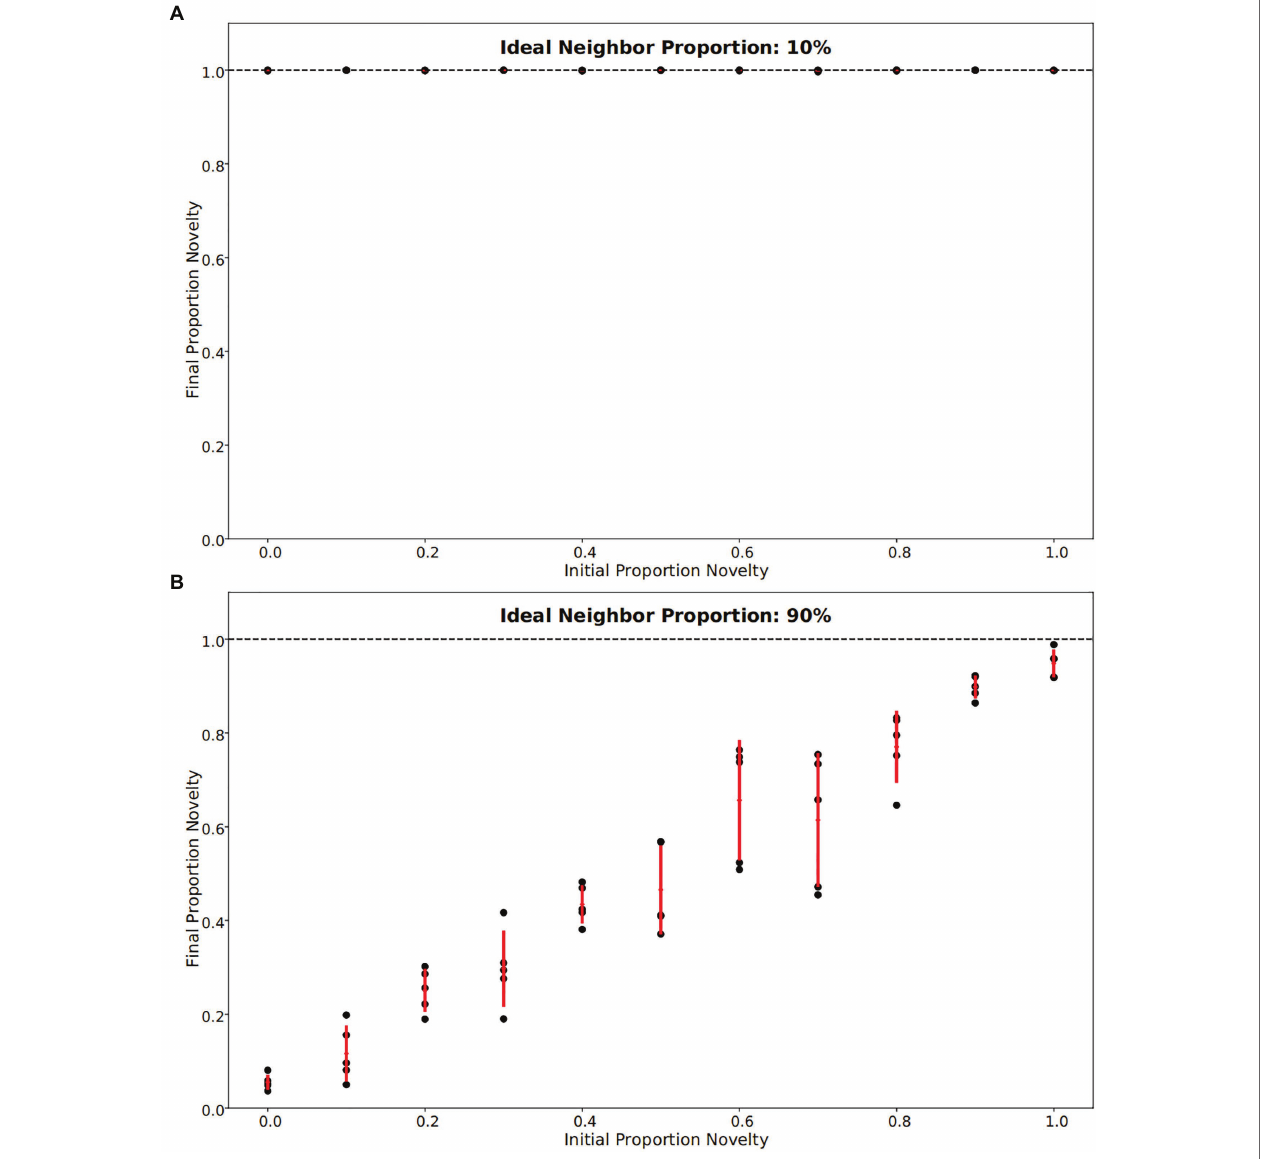
FIGURE 1 | Final fraction of novelty preference in the population after 4,000 iterations, for a range of initial novelty preferences. Each of five replicates per ideal neighbor proportion are represented by a black point, with one standard deviation from the mean marked by red lines. (A) For populations in which rare cultural traits are favored (an ideal neighbor proportion of 10%), novelty preference was strongly selected for, such that all populations were almost entirely made up of individuals with a novelty preference at the end of the simulations. (B) Populations that favor conformity (ideal neighbor proportion of 90%) show little selection against individuals with novelty preferences, as these remain at nearly the same frequency over the course of the